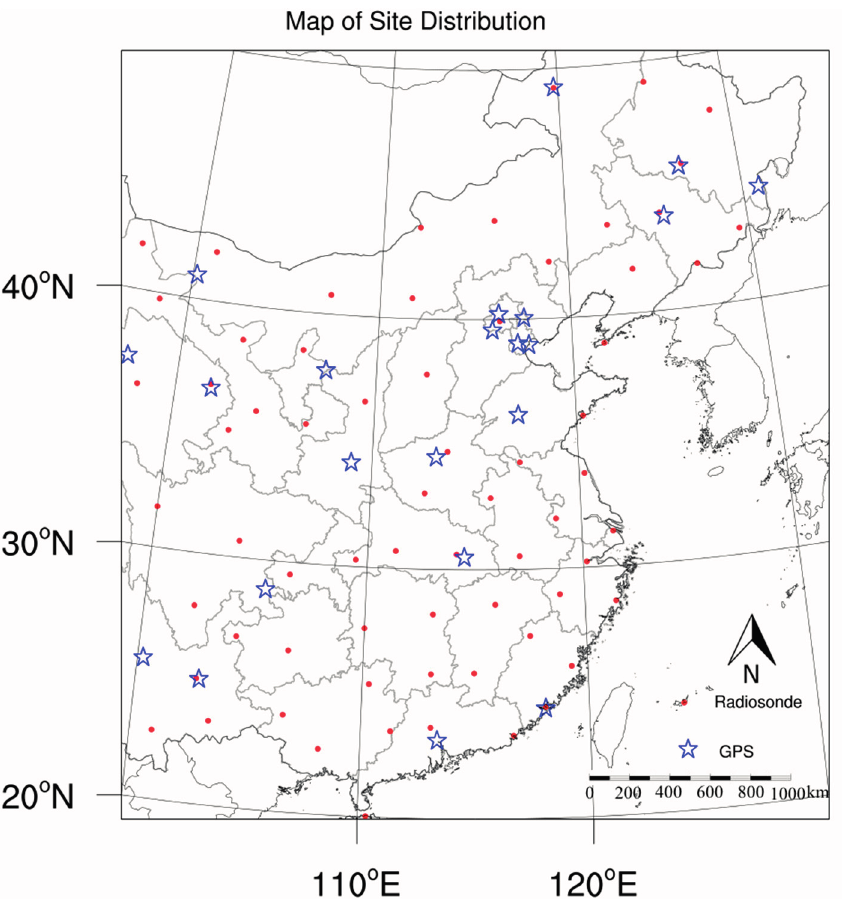
Figure 1. Spatial distribution of radiosonde and Global Positioning System (GPS) stations over eastern